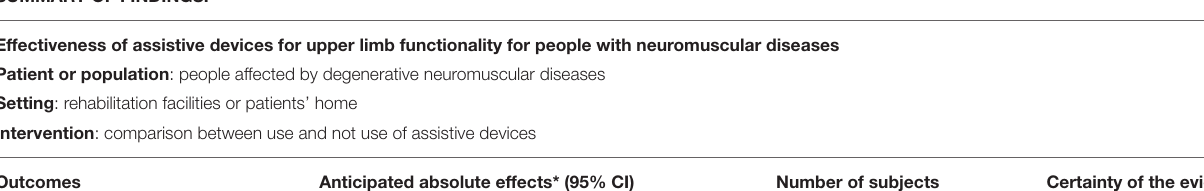
TABLE 7 | Summary of findings table for the main